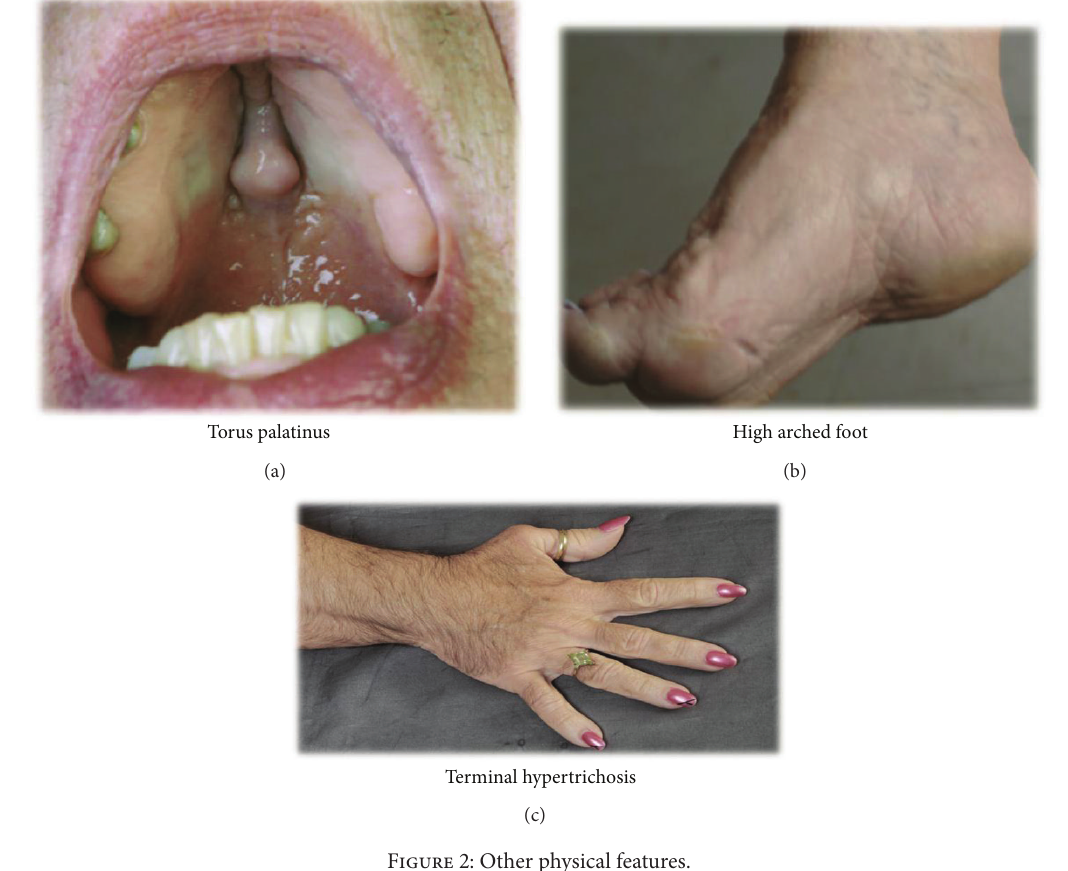
Figure 2: Other physical